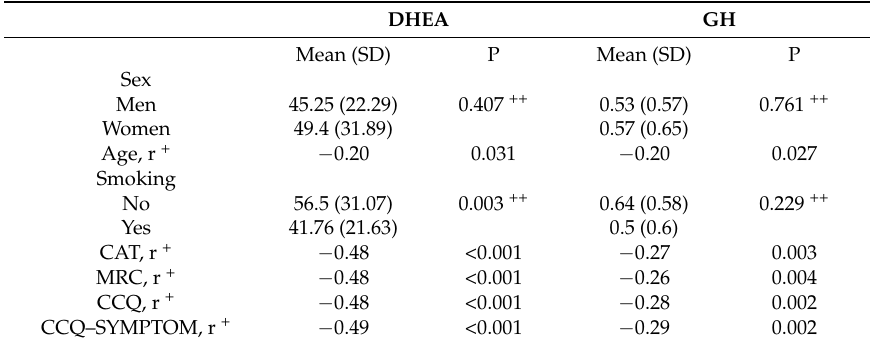
Table 3. Association of DHEA and GH with demographic dyspnea indices and quality of life dimensions.